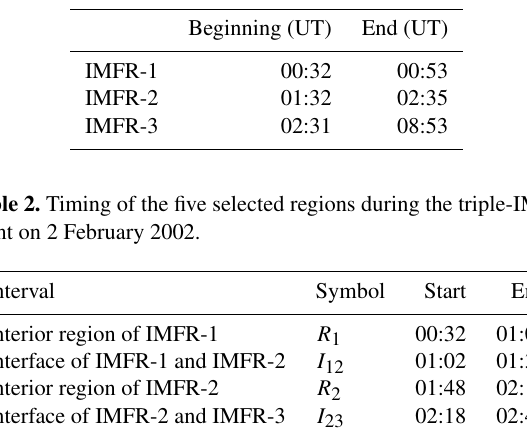
Table 1. Beginning and end of the intervals depicted in Fig. 1, cor- responding to the boundary layers of three interplanetary magnetic flux ropes (IMFRs) on 2 February 2002.